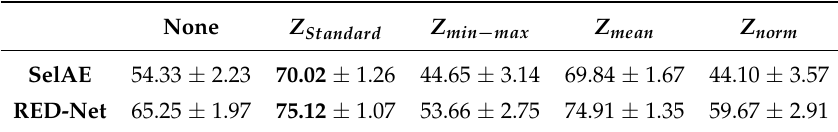
Table 2. Average F 1 (%) plus σ when applying different types of normalization on the input data, and without normalization. None Z